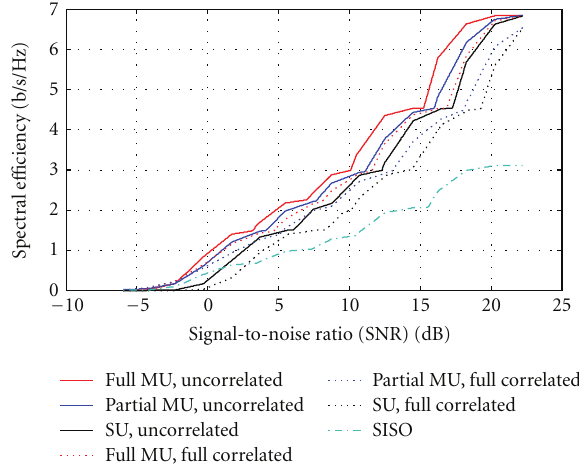
Figure 8: Average bandwidth e ffi ciency comparison between the uncorrelated and fully correlated channels in the partial feedback